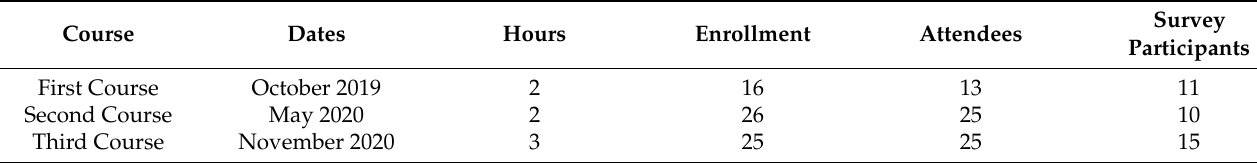
Table 2. Courses implemented at the